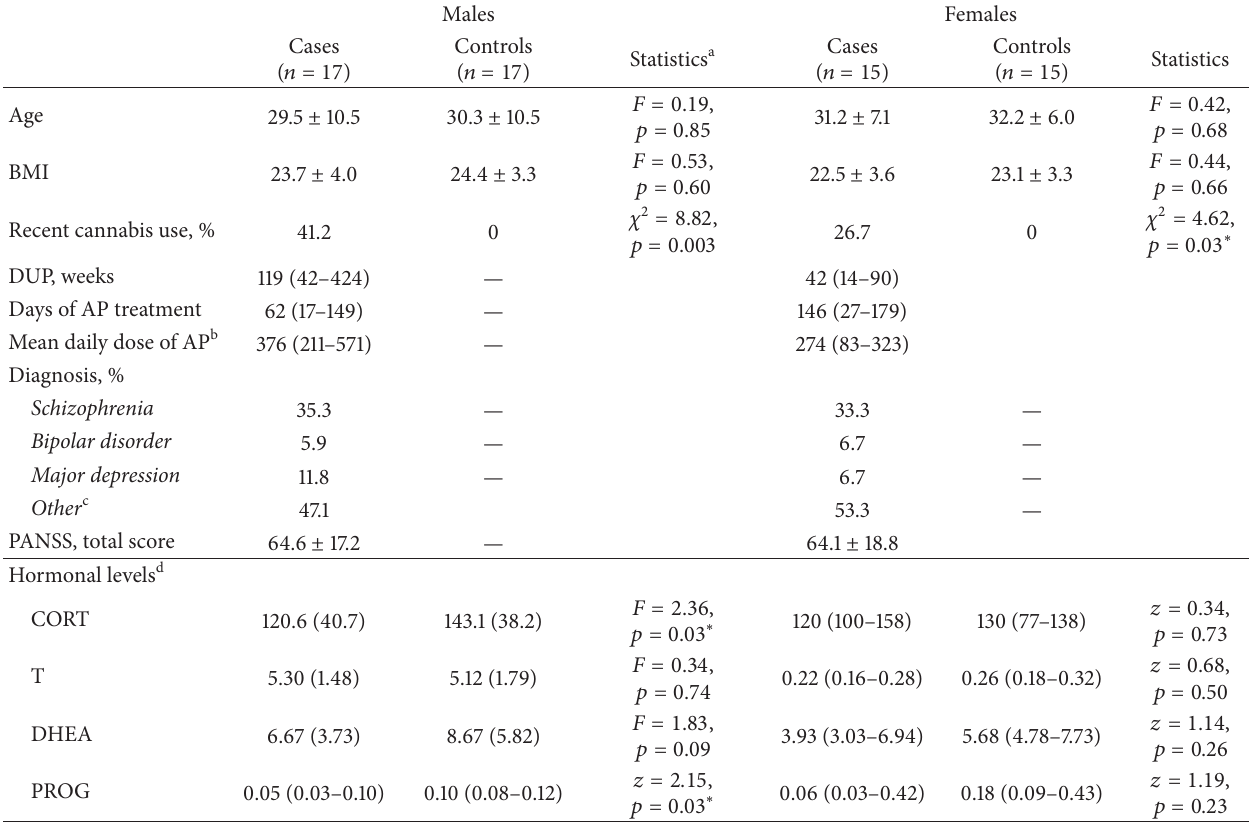
Table 1: Comparison between cases and